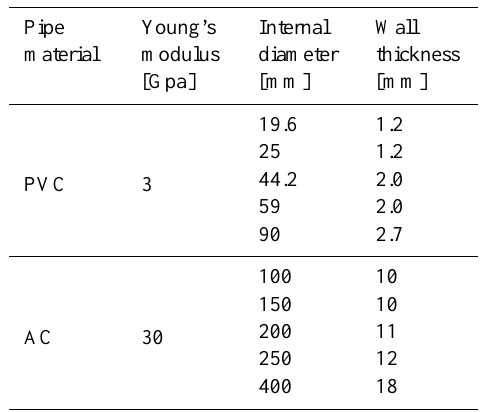
Table 1. Pipe properties for waterhammer model for pipes with a pressure rating of 6 barg.